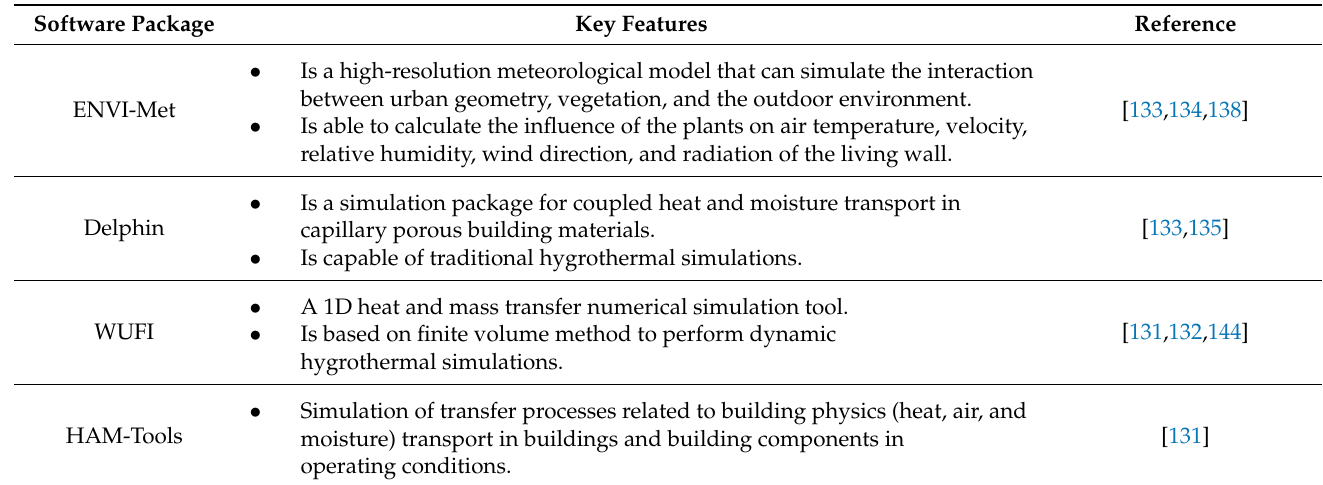
Table 10. Key hygrothermal modeling software summary for package